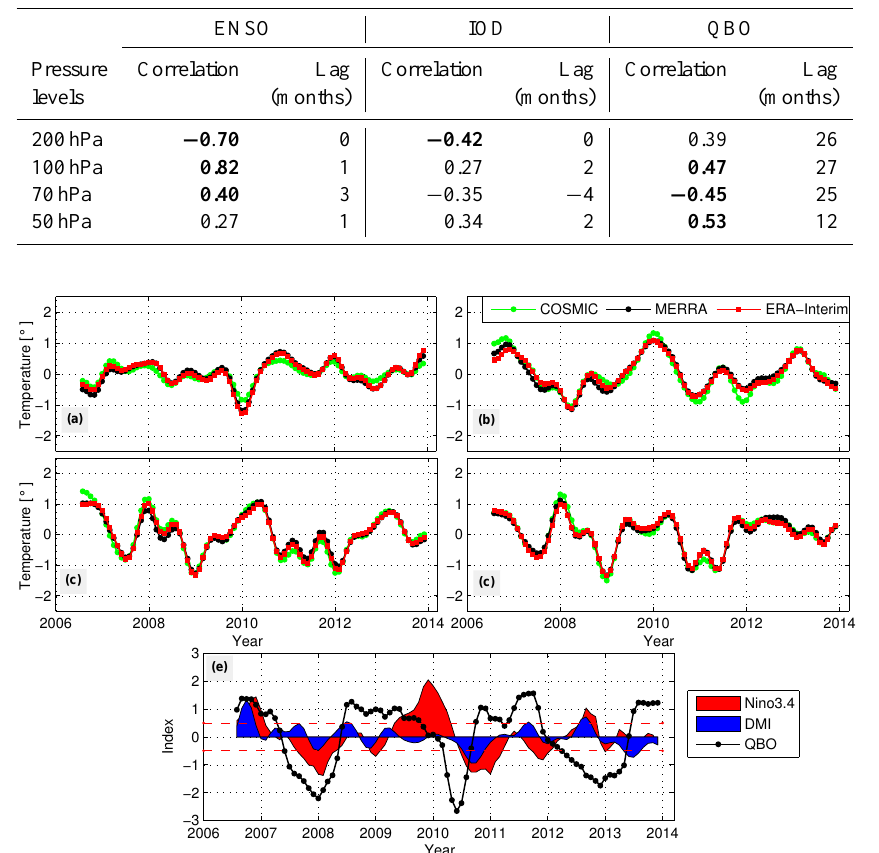
Figure 7. Interannual variability of temperature ( ◦ C) at (a) 200hPa, (b) 100hPa, (c) 70hPa, and (d) 50hPa from August 2006 to December 2013 based on COSMIC RO, MERRA, and ERA-Interim. (e) Ocean–atmospheric indices: Niño3.4, DMI, and QBO are also plotted for